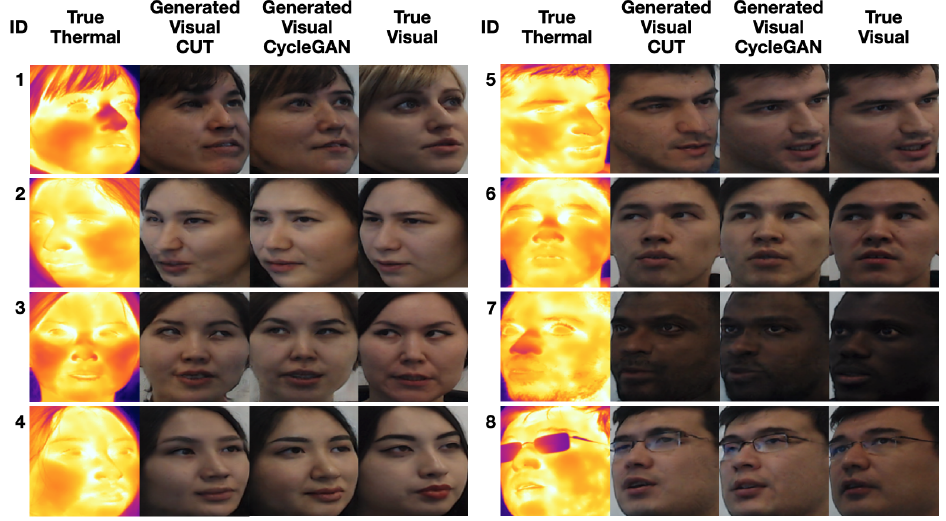
Figure 9. Thermal-to-visual image translation results using CycleGAN. For each column, left to right: real thermal image; generated visual image by CUT; generated visual image by CycleGAN; and real visual image.